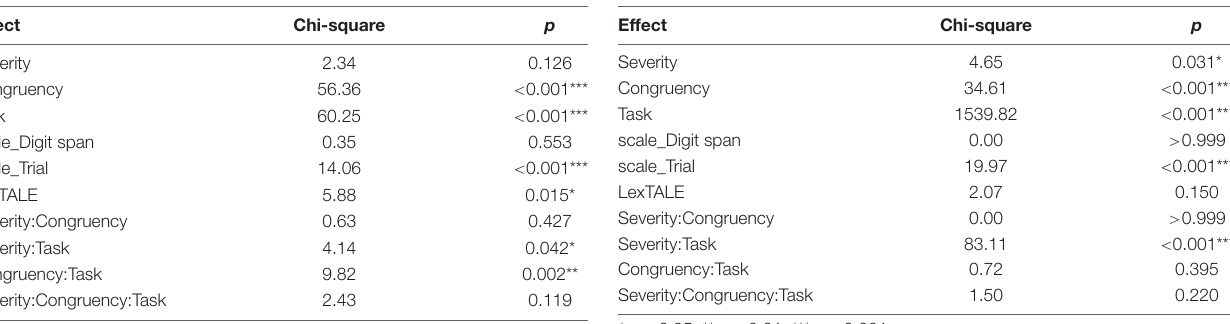
TABLE 5 | Linear mixed-effects model with severity, congruency, task as the fixed effects and the logarithm of reaction time as dependent variables in Experiment